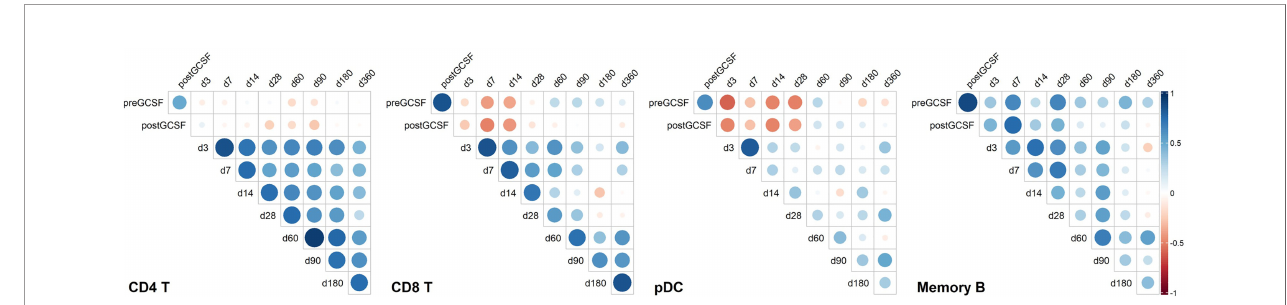
FIGURE 5 | Correlation heatmaps of selected immune cell populations and on selected time points. Unclustered correlation (Spearman) of selected immune cell populations between donors and recipients identi fi es strong positive association of donor B-cell counts with early timepoints post transplantation, negative association of donor plasmacytoid dendritic cell (pDC) counts and donor CD8 T cell counts with early immune reconstitution, and positive association of early recipient CD4 T cell counts with later recipient CD4 T cell counts. CD4 T, CD4 T helper cells; CD8 T, CD8 T cytotoxic cells; pDC, Plasmacytoid dendritic cells; Memory B, Memory B cells. Timepoint (n): preGCSF (18), postGCSF (21), d3 (20), d7 (20), d14 (21), d28 (21), d60 (20), d90 (20), d180 (19), d360